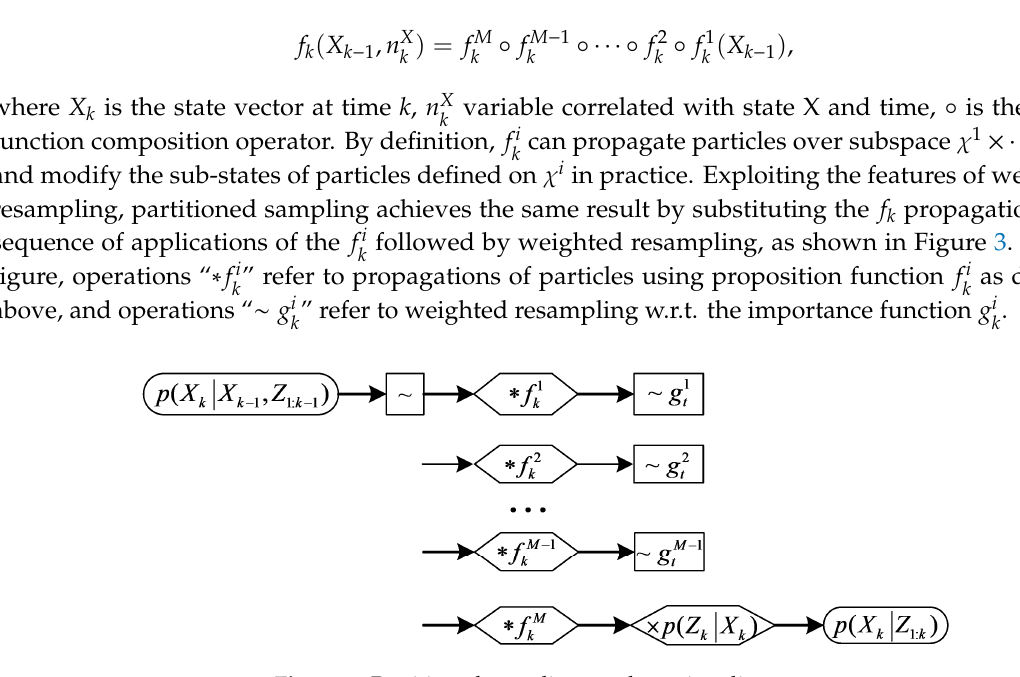
Figure 3. Partitioned sampling condensation diagram.